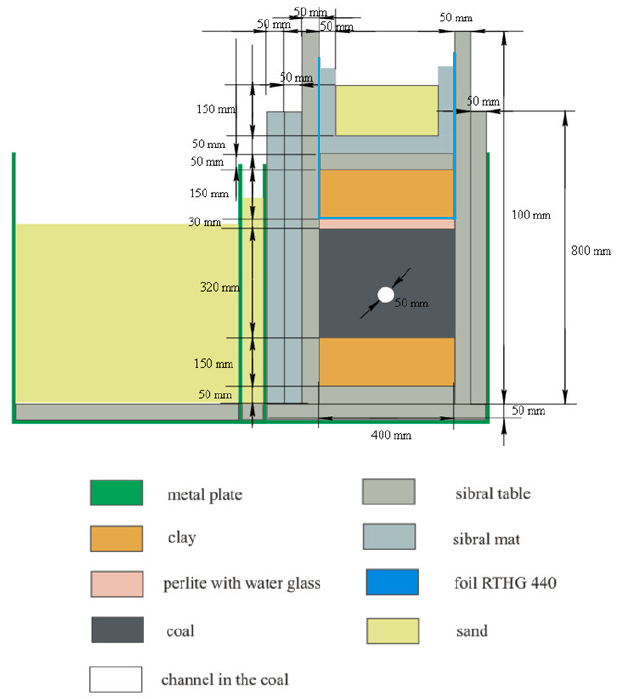
Figure 2. The scheme of the cross-section for the physical model of the coal seam for the first exper- iment.